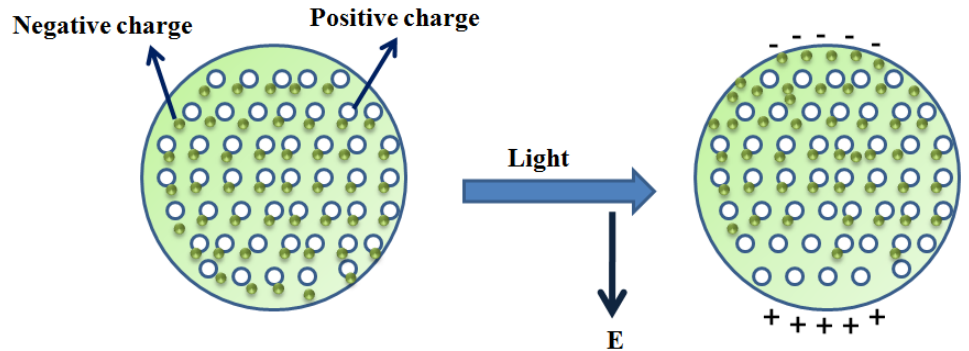
Figure 3. Schematic showing the dipole formation outside the metal nanoparticle in the presence of an oscillating EM field.